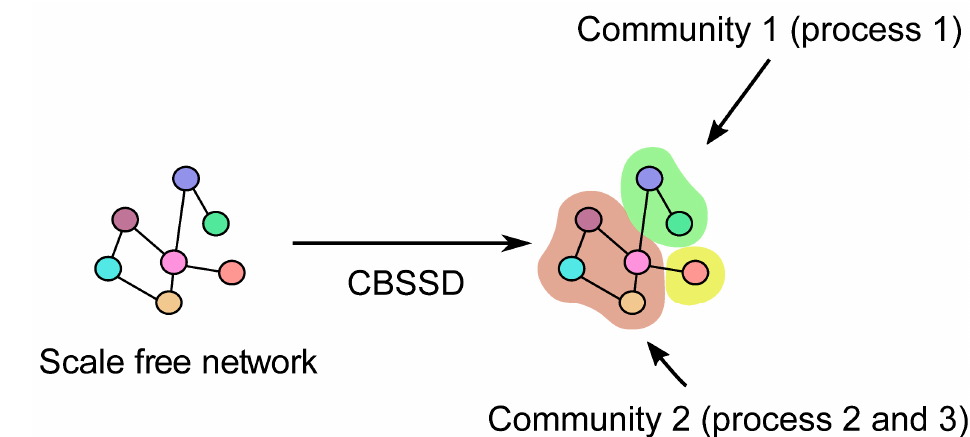
Figure 3. Overview of the community-based semantic subgroup discovery (CBSSD) methodology. Given a complex network, CBSSD offers the functional enrichment of communities within the network. The functional enrichment corresponds to the assignment of expert-derived process descriptions to parts of the communities.